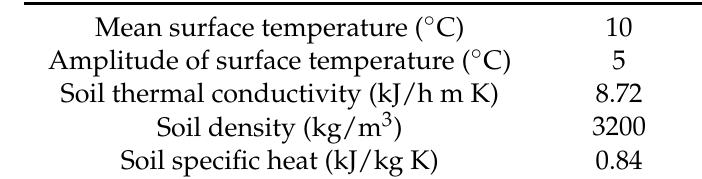
Table 8. Boundary conditions: the ground